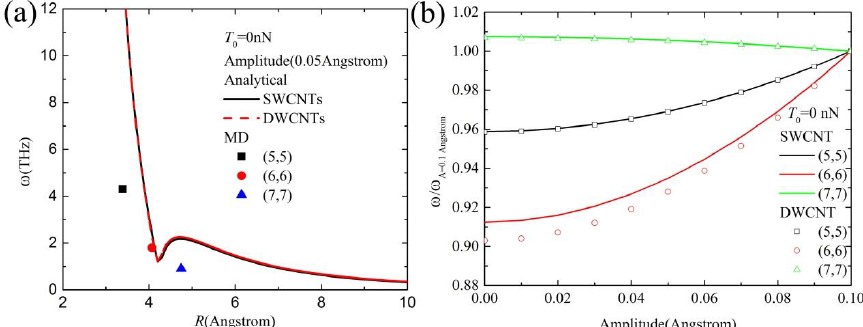
Figure 3. ( a ) The vibration frequency distribution of a carbon chain in different SWCNTs and DWCNTs by continuum modeling and MD simulations; ( b ) The amplitude effect on the normalized vibration frequency distribution.